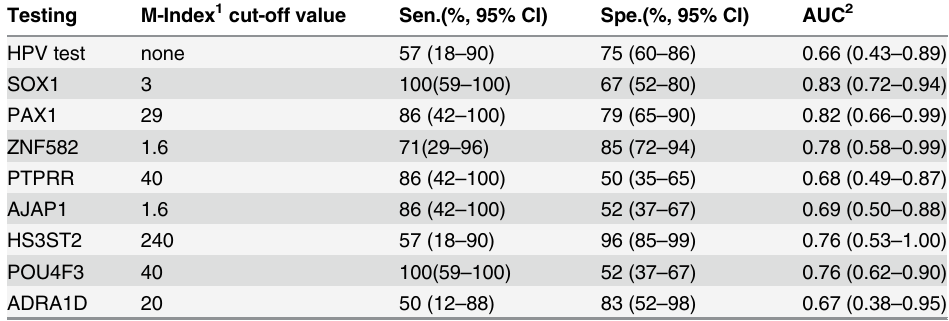
Table 2. Clinical performance of methylation biomarker and HPV to detect CIN3 + /CIS and complex hy- perplasia of endometrium in